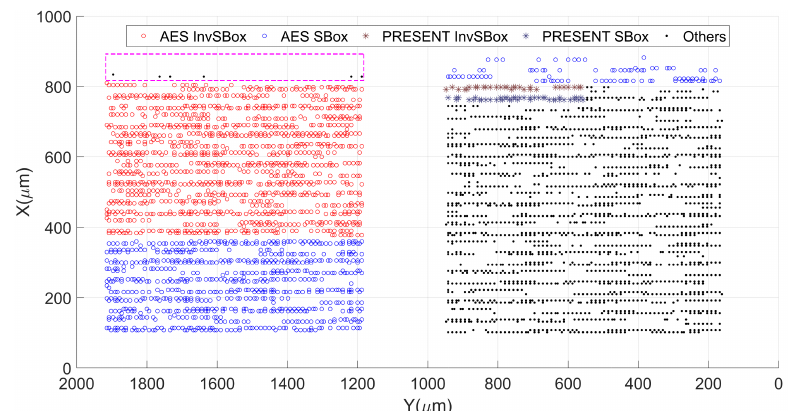
Figure 9: Scanning results of SRAM.